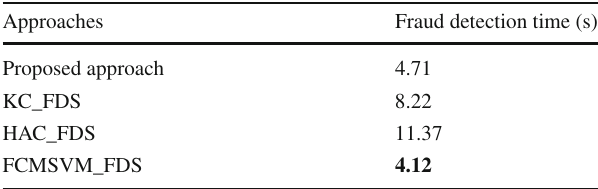
Table 9 Comparison of various approaches w.r.t fraud detection time